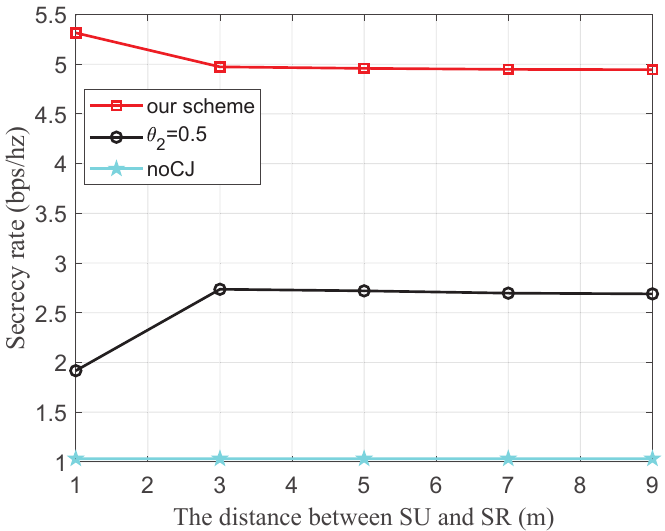
Figure 9. The secrecy rate versus the distance between SU and SR.